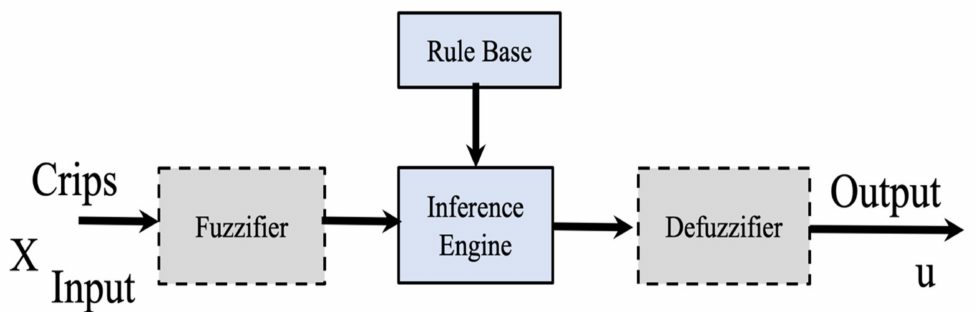
Figure 1. Structure of a T1FLS.